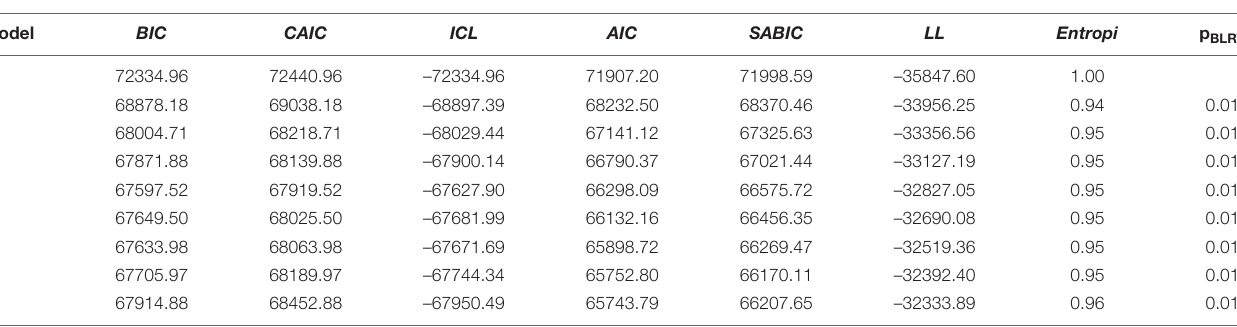
TABLE 2 | Latent profile analysis of stress: Statistical fit